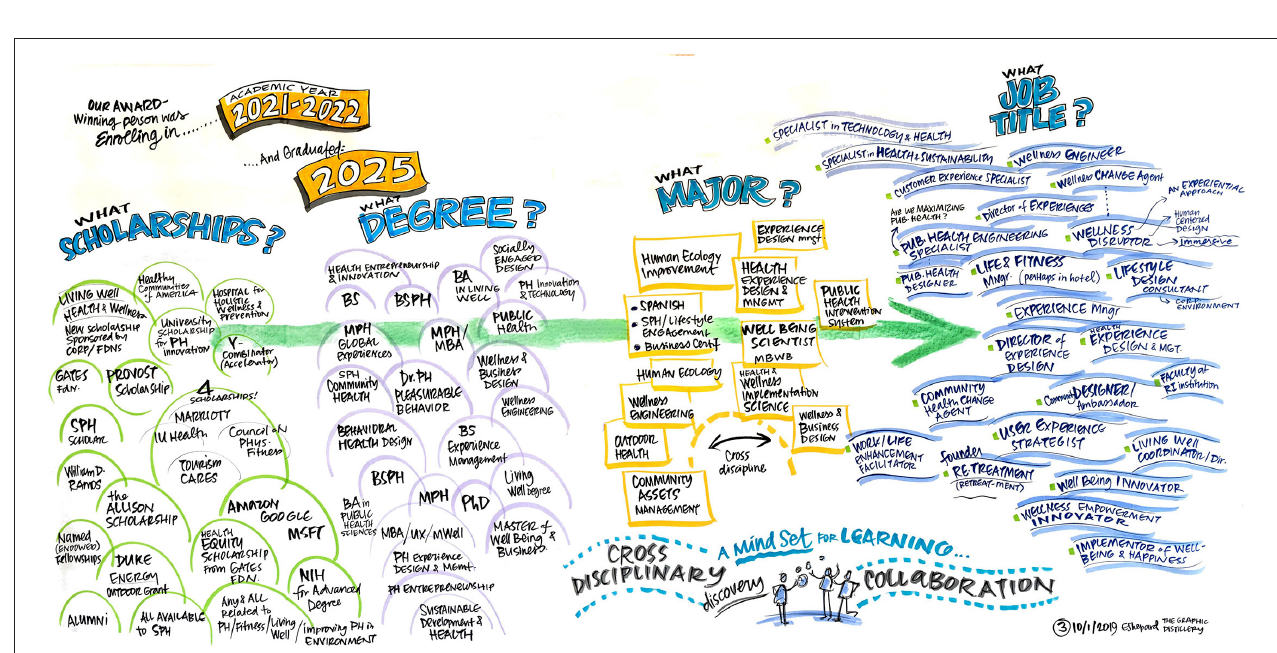
FIGURE 4 | Imagine the first round of graduates of our new program - what does their future look like?